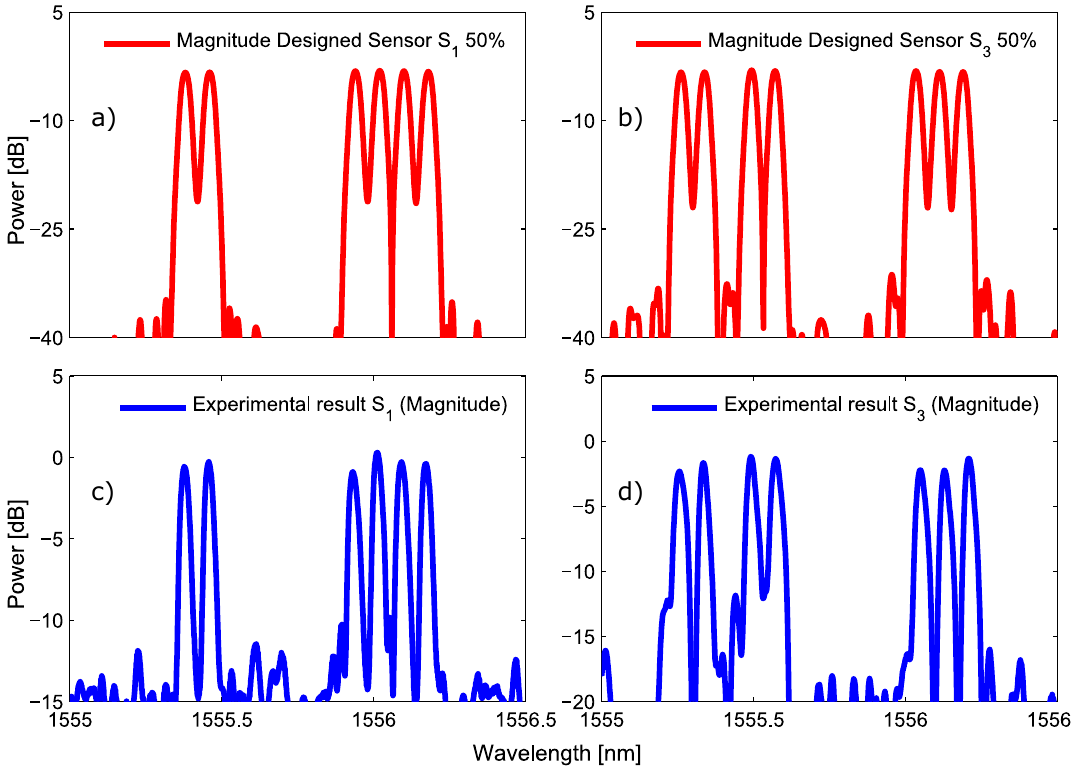
Figure 8. The measured magnitude of the manufactured SSFBG is depicted in ( c , d ) for the devices S 1 and S 3 . The designed magnitude of this sensors is shown in ( a , b ) for